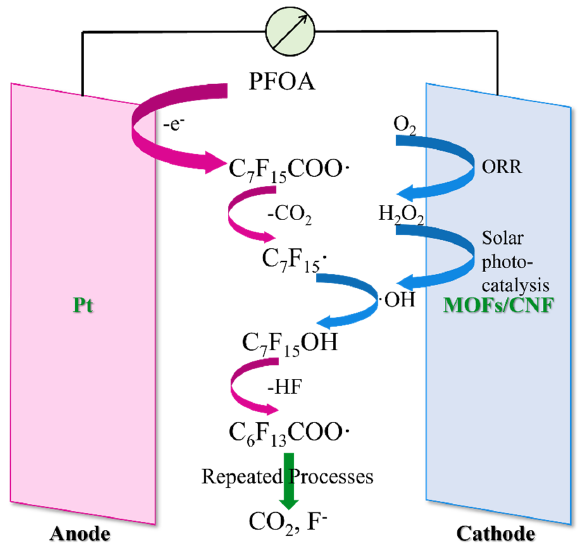
Figure 5. Mechanism of PFOA mineralization by the MOFs/CNF constructed SPEF system. Reprinted with permission from reference Yang Wang, Mingzhen Zhao, Chen Hou, Wenqiang Chen, Shuaishuai Li, RongKai Ren, Zhijian Li, 2021,